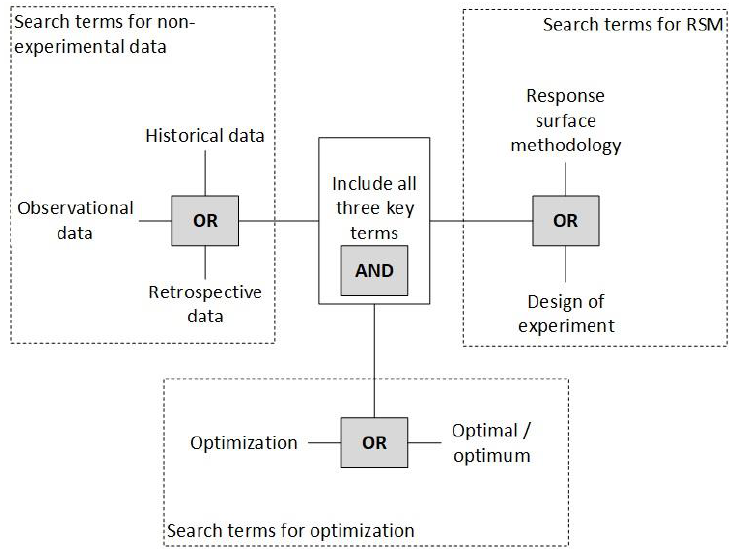
Figure 4. Search string and Boolean